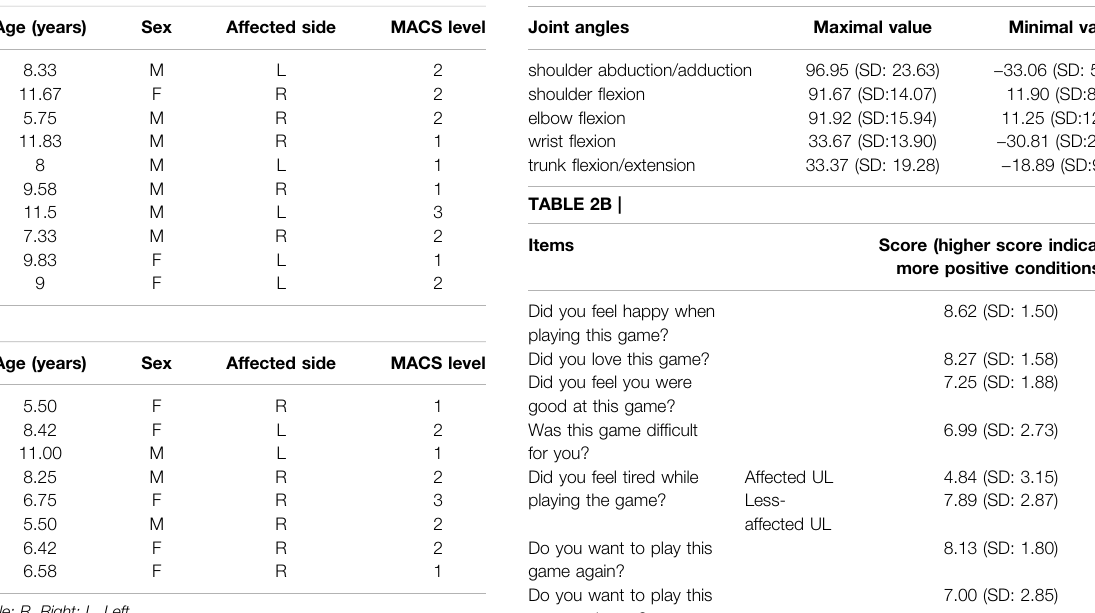
TABLE 1A | Demographic data of participants in feasibility study (A) and effectiveness study (B).